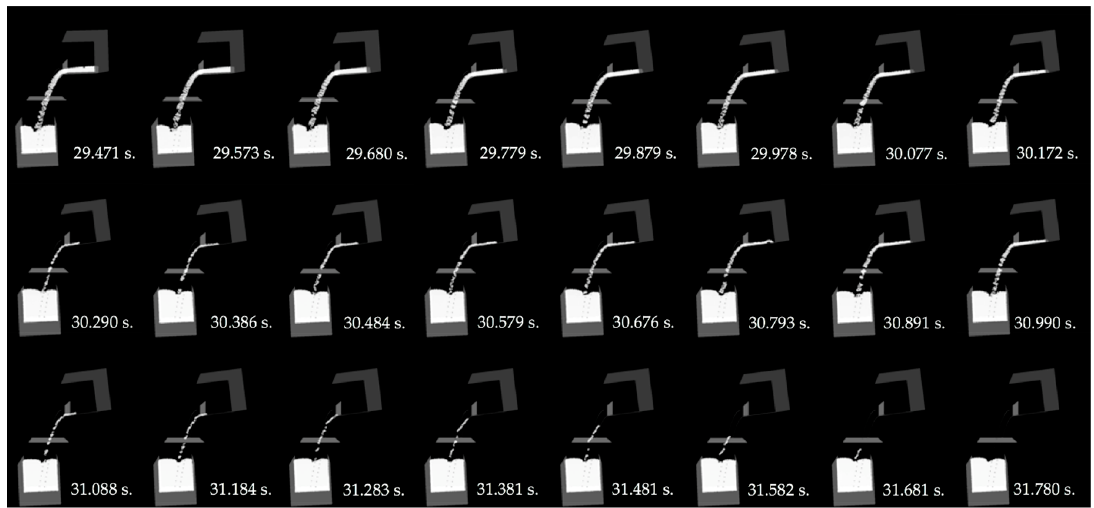
Figure A2. Simulated time sequence of the vessels using the SIM timeline (Figure 7), including all particles. A full sequence video (S1) can be found in the supplementary material Section.